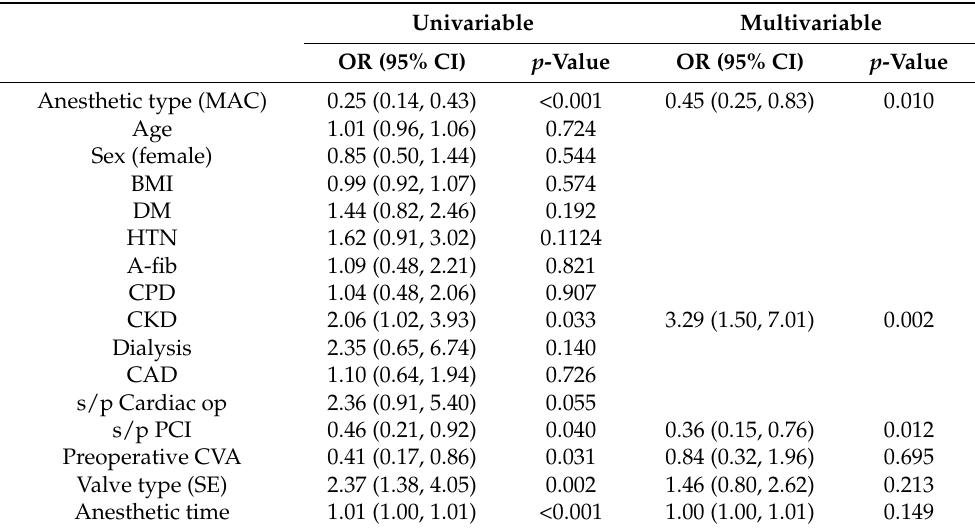
Table 3. Univariable and multivariable logistic regression analysis of factors associated with postop- erative pulmonary